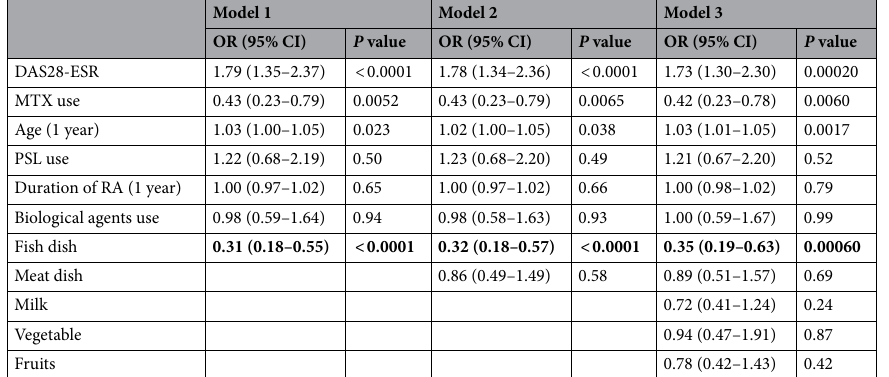
Table 4. Multivariate logistic analysis for RA patients with prefrailty or frailty together with dietary habits. Results of multivariate logistic regression analysis with dietary habits and RA-related factors regarding the presence of prefrailty or frailty. Model was adjusted for age, RA duration, RA therapeutics (use of prednisolone, biologics and methotrexate), DAS28-ESR, and dietary habits (only fish dish (model 1), fish + meat dishes (model 2) and fish/meat/milk/vegetable/fruits (model 3) as variables). Dummy variables were constructed for intake frequency as 0 and 1: Fish and Meat dish: 0 = low frequency (≤ 2 times/weeks), 1 = high frequency (3 times/week ≤) and Milk, Vegetable and Fruits: 0 = low frequency (≤ 6 times/week), 1 = high frequency (1 time/ day ≤). RA rheumatoid arthritis, DAS28-ESR 28-joint Disease Activity Score using erythrocyte sedimentation rate, MTX methotrexate, PSL prednisolone.